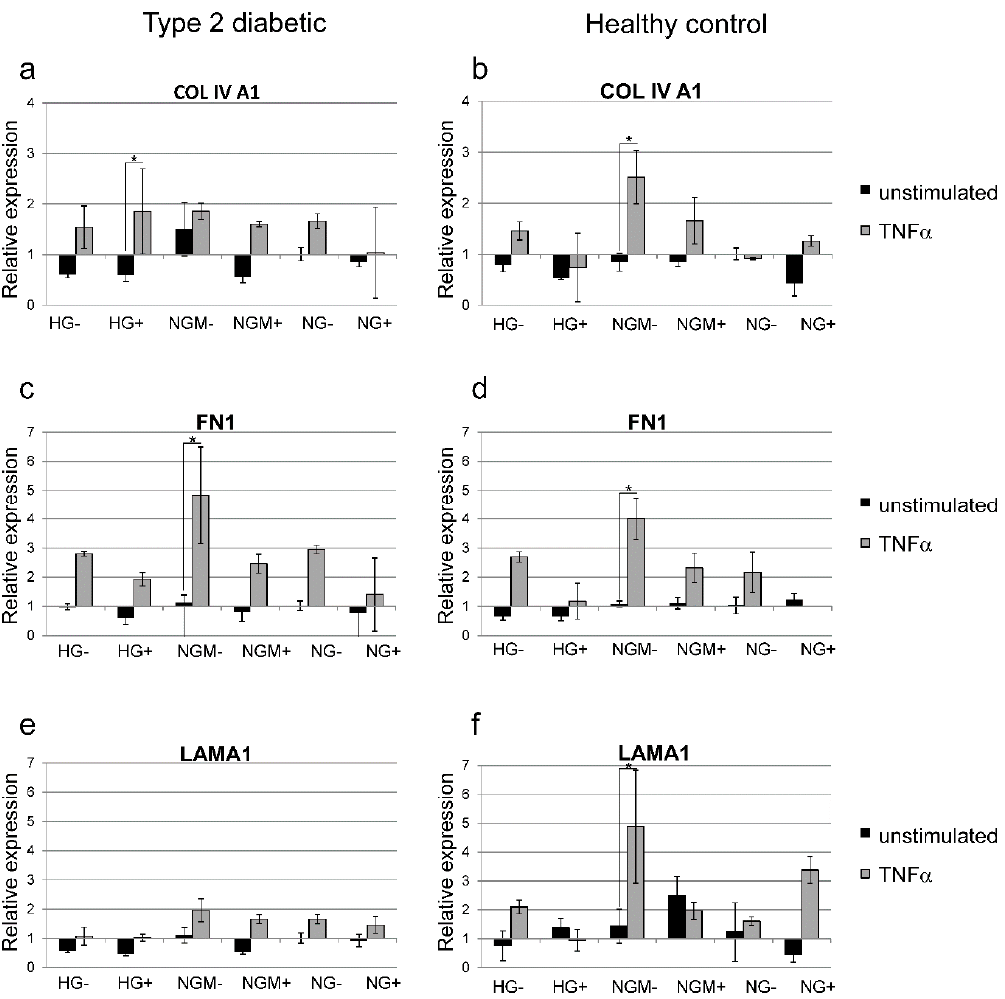
Figure 10. Effects of different glucose concentrations, and cytokine and oxidative stress on Collagen IV ( COL4A1 ), fibronectin ( FN1 ), and laminin A1 ( LAMA1 ) gene expression in hiPSC-RPEs derived from type 2 diabetic (UTA.08203.DMs: ( a , c , e )) or healthy control (UTA.10902.EURCCs: ( b , d , f )) patients. The hiPSC-RPEs were cultured in different glucose and insulin concentrations (see treatments and abbreviations below) in the presence or absence (+/ − ) of added insulin, and in the presence or absence of TNF α (48 h treatment). Overall, the 48 h TNF α treatment induced COLA1 , FN1 , and LAMA1 expression. The housekeeping gene GAPDH was used as a loading control and calibrator. Data are expressed as mean ± SD of three replicates. The statistical significance is presented against the control: * p ≤ 0.05. Treatments and their abbreviations: high glucose (HG, 25 mM), normal glucose 5 mM balanced with mannitol 19.5 mM (NGM), or normal glucose (NG, 5 mM) in the presence or absence (+/ − ) of added insulin.